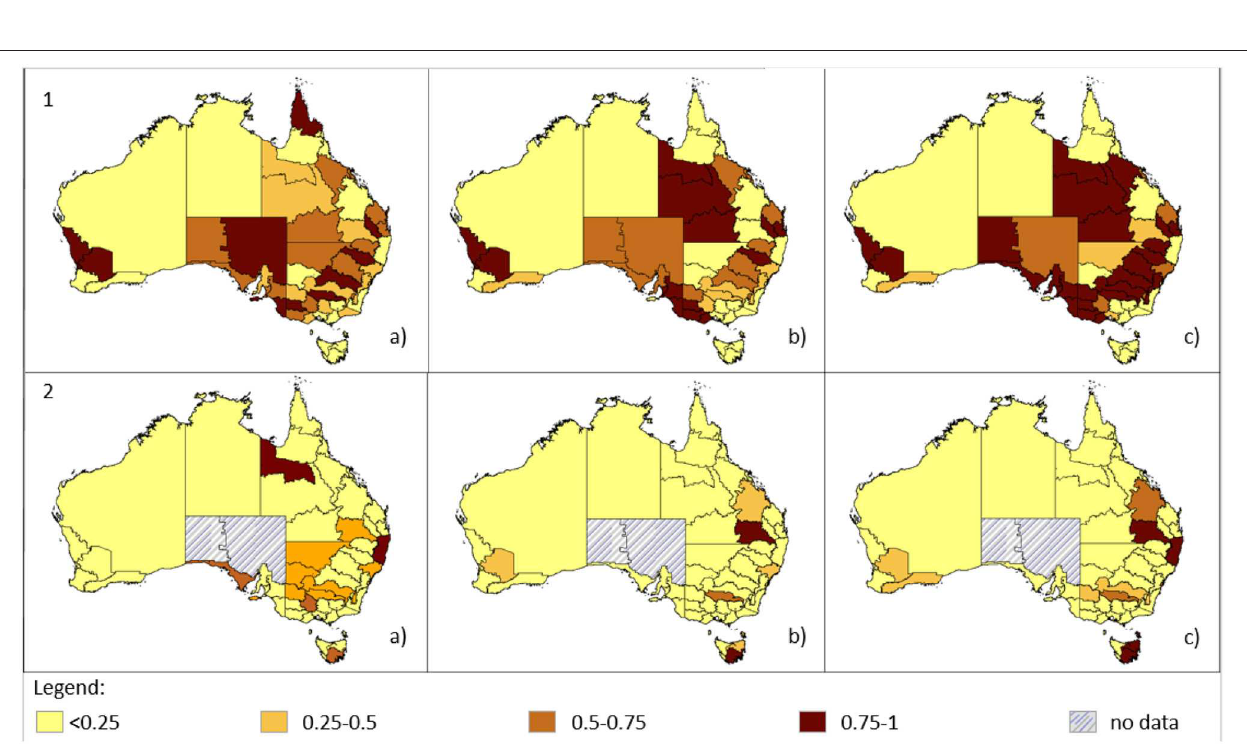
FIGURE 5 | Maps of criteria of performance on the environmental (1) and socio-economic (2) aspects. The figure shows, the Overuse/Overexpenditure (a), the non-Reliability (b), and the non-Resilience (c) of groundwater use for irrigation purposes in the Australian continent.